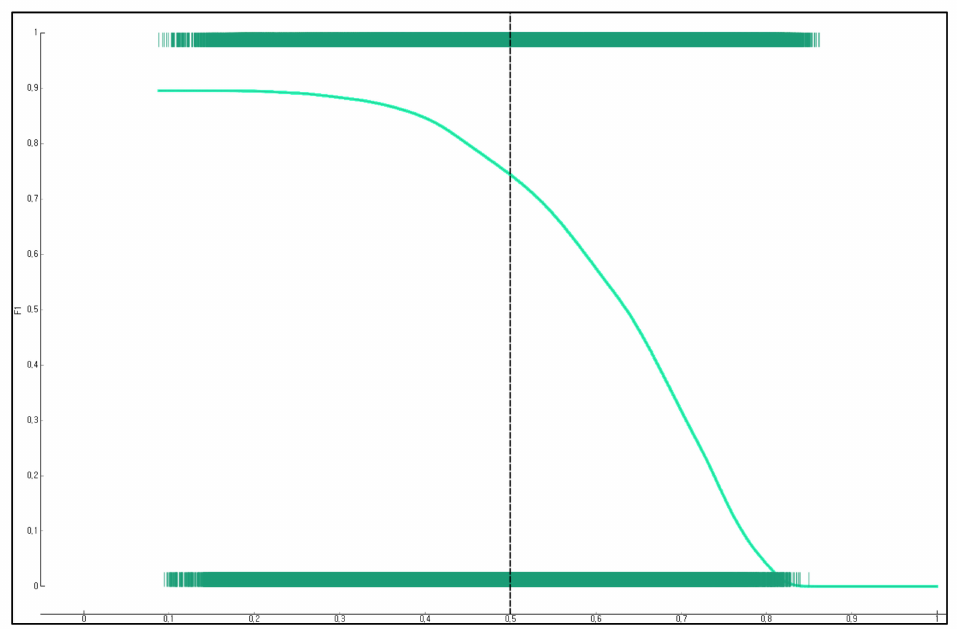
Figure 8. F-1 score of the nomogram for predicting anxiety due to COVID-19 for adults living in South Korean communities.